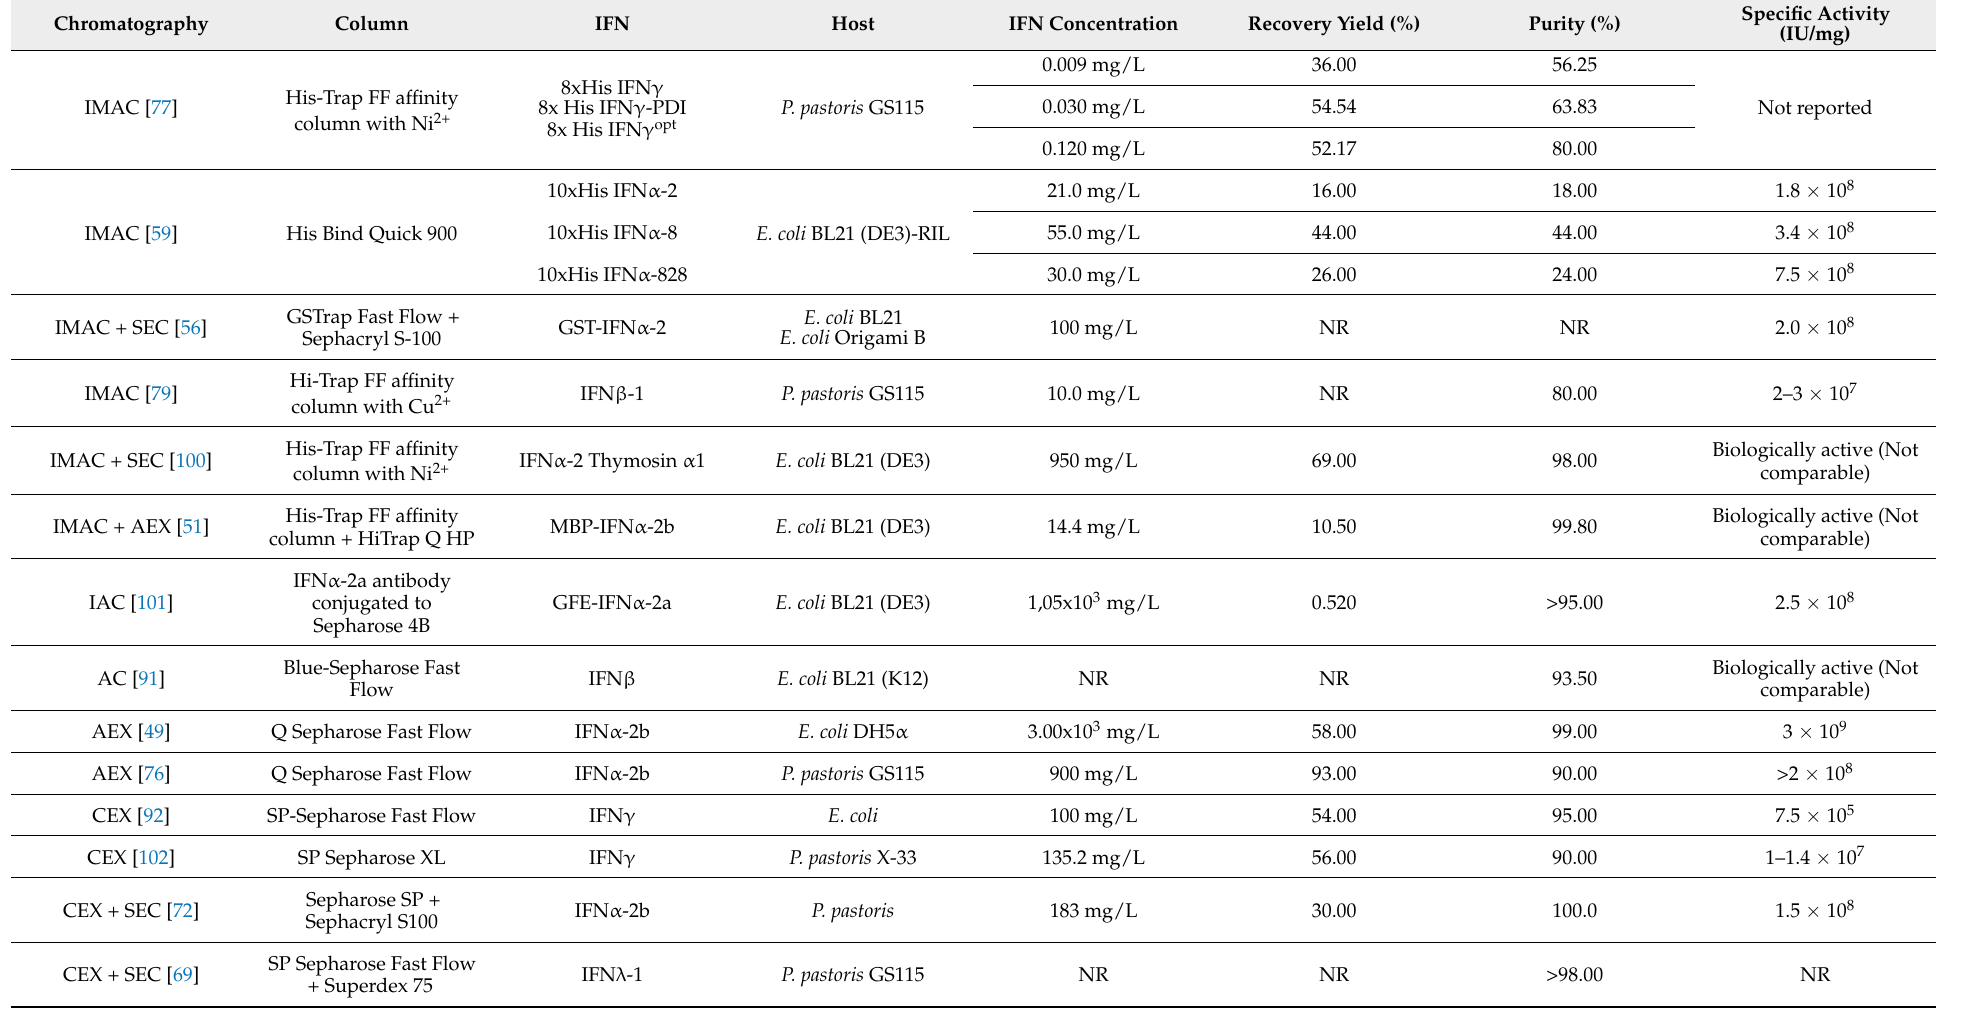
Table 5. Representative studies of the application of chromatographic techniques for the purification of distinct classes of recombinant therapeutic IFNs.